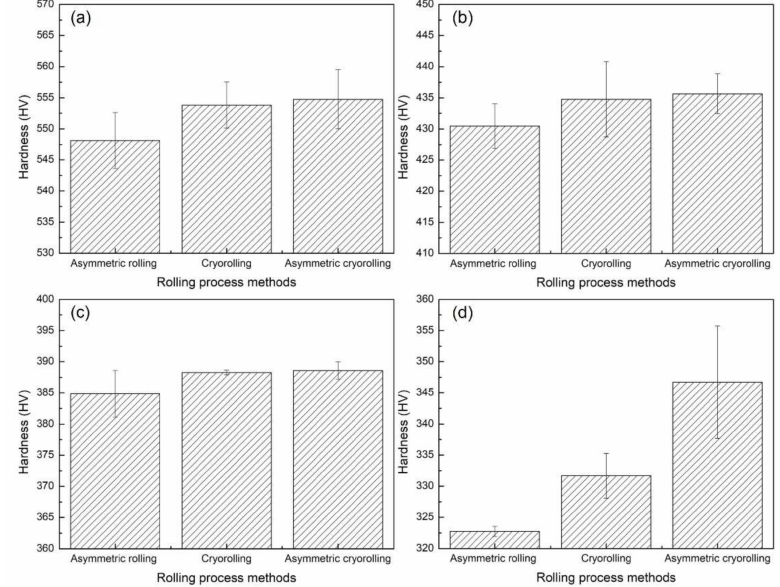
Figure 6. The hardness change diagram of the CoCrNi MEA ( a ) after asymmetric rolling, cryorolling, asymmetric cryorolling, and subsequent annealing at ( b ) 600 ◦ C, ( c ) 700 ◦ C, ( d ) 800 ◦